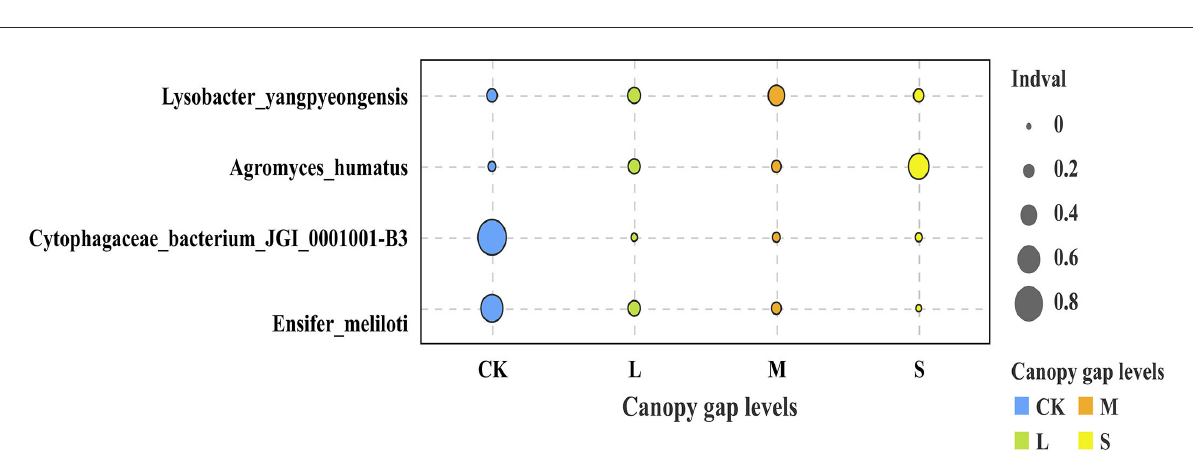
were significantly different across the sampling plots with small, medium, and large gaps ( p < 0.05; Figure 4). The functions of the top 10 bacteria with the highest relative abundance at level 2 were nearly similar in the sampling plots with different forest gap sizes (Supplementary Figure S2), in which a relative abundance greater than 10% was the main function, and included the metabolism of cofactors and vitamins, amino acid metabolism, and carbohydrate